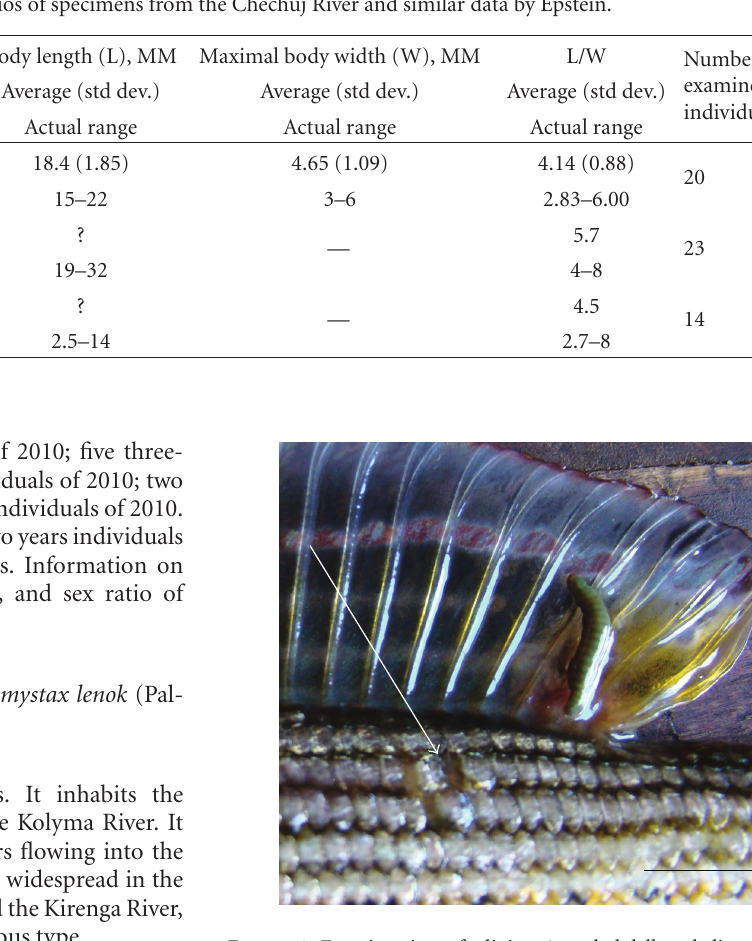
Figure 3: Exterior view of a living Acanthobdella peledina from the Chechuj River. The arrow points to three ulcerous openings left by the parasite in the soft tissues of their host. Bar is equal to 1